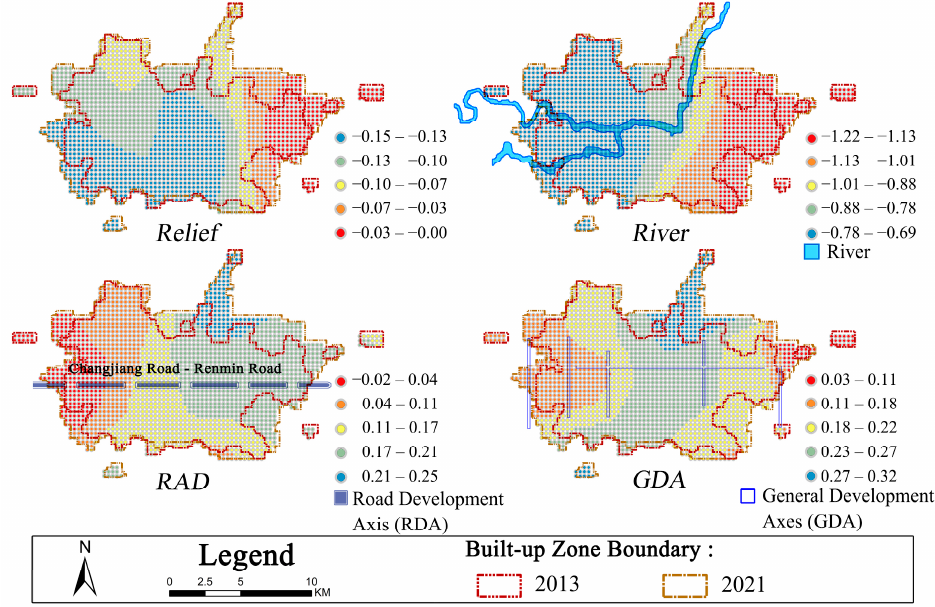
Figure 7. Heterogeneity impact of semi-global factors on LCI.